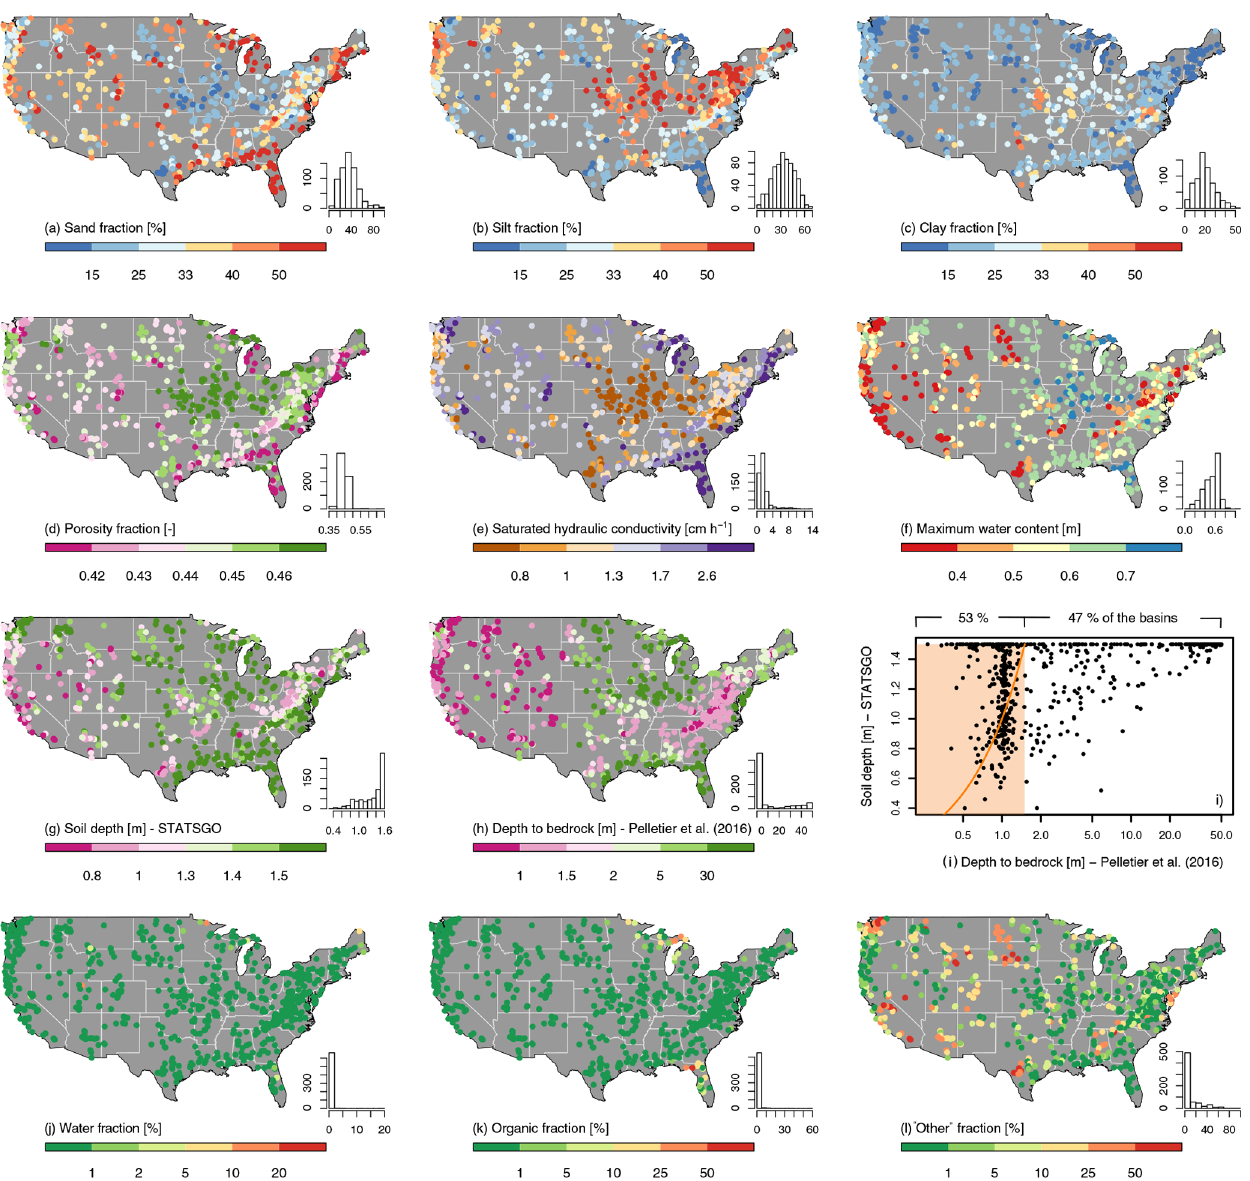
Figure 6. Panels (a–h) and (j–l) show maps of soil characteristics over the CONUS. The histograms indicate the number of catchments (out of 671) in each bin. (i) Comparison of the estimates of the soil depth to bedrock from STATSGO and depth to bedrock from P16. The orange area includes all the catchments for which there can be an agreement between the two data sets (i.e., estimates from both data sets are smaller than or equal to 1.5m). The orange curve is a 1:1 curve (note the logarithmic scale on the x